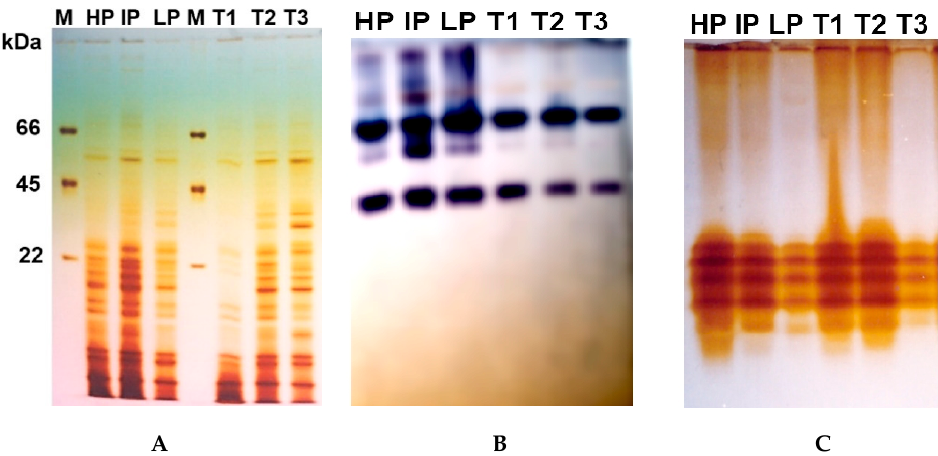
Figure 9. ( A ) Protein expression profile of SDS-PAGE extracted from A. flavus mycelium treated with a high Cu-Chit/NCs gel concentration. Lane M shows a standard protein molecular weight marker. Protein marker including three molecular bands ranging from 66, 45, and 22 kDa was used. Isoenzymes electrophoresis of G6PD ( B ) and peroxidase ( C ) isozymes extracted from A. flavus mycelium treated with a high Cu-Chit / NCs gel concentration.